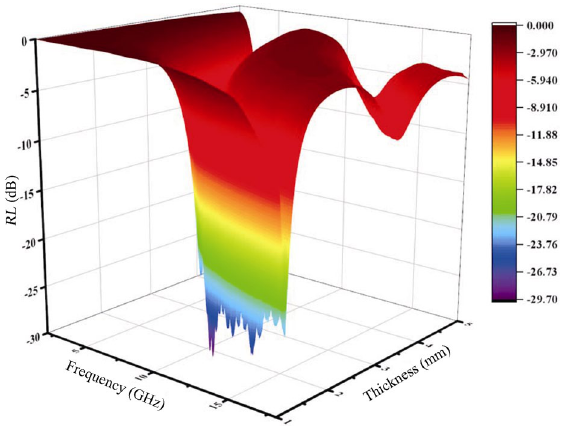
Fig. 9 3D representation of reflection loss values for the 3D-SiC/MDCF-II-wax